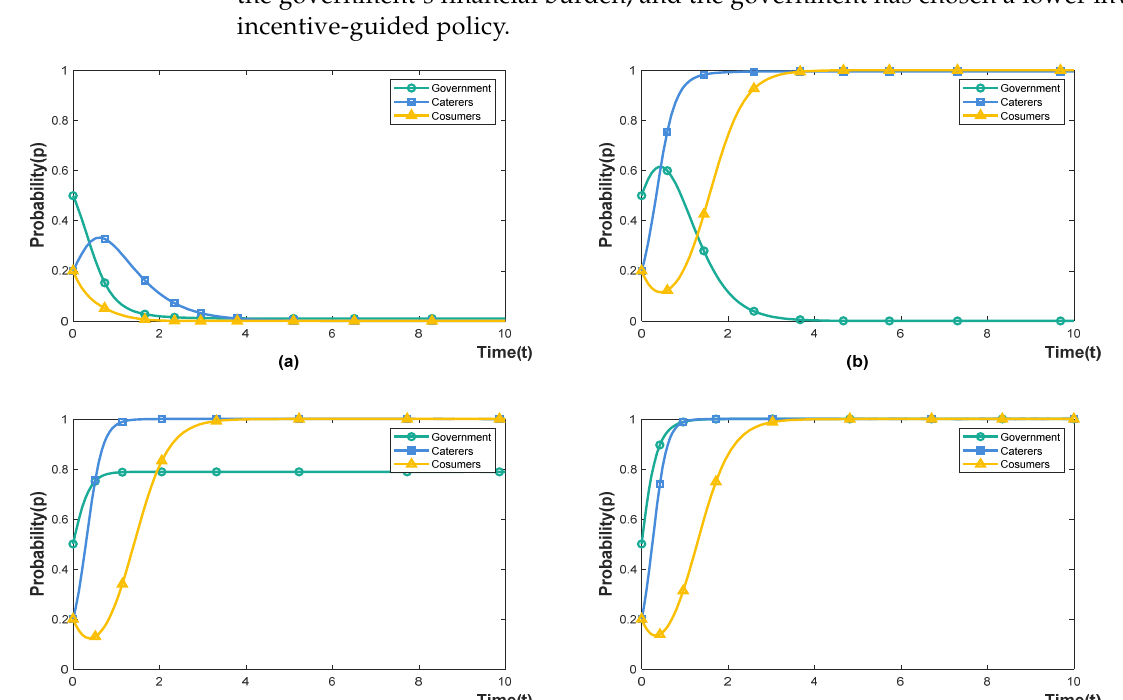
Figure 3. The influence of government punishment. ( a ) β = 0.2. ( b ) β = 0.5. ( c ) β = 0.6. ( d ) β = 0.8 .